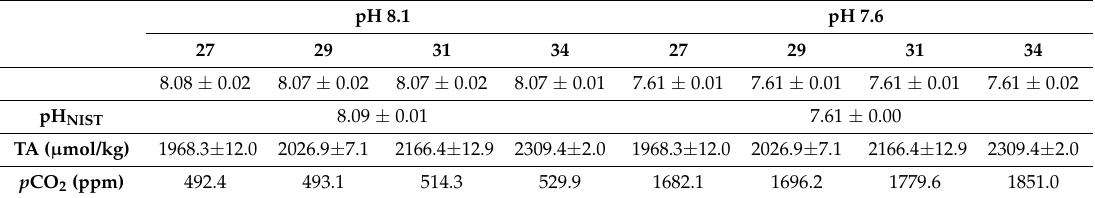
Table 1. Experimental pH conditions in experiments with A. cf. solaris . Mean values for pH NIST ( ± SE, n = 3) for each salinity across experimental runs is presented, as well as the overall mean pH NIST ( n = 12). p CO 2 was calculated in CO2SYS using data on total alkalinity (TA, n = 2–4 per salinity), salinity, and pH NIST